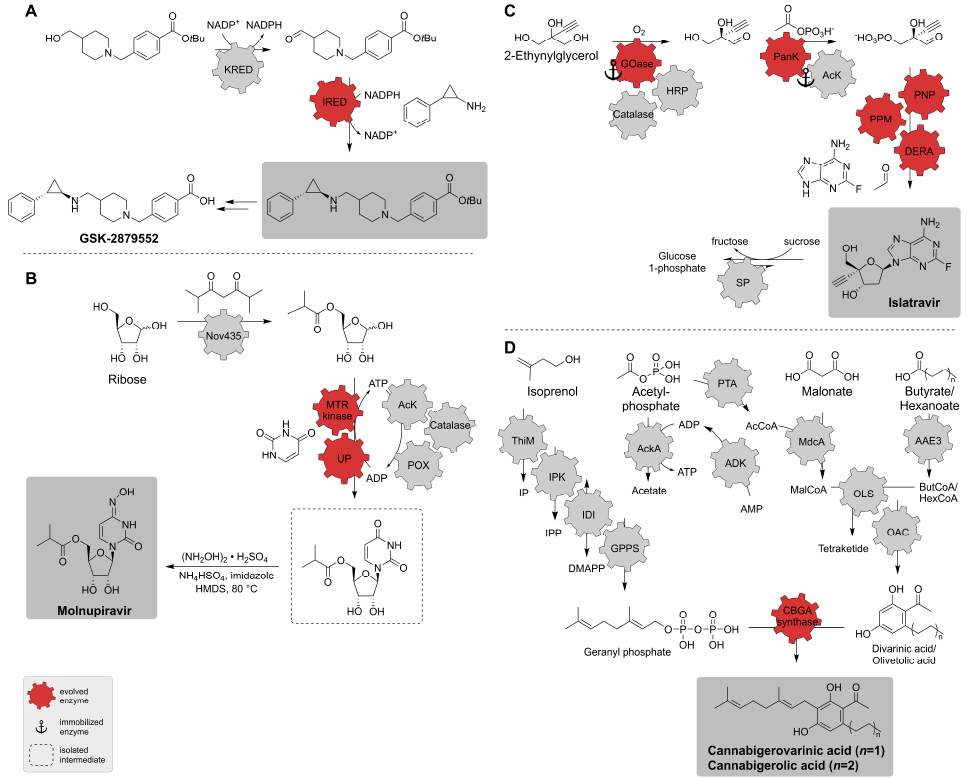
Figure 14. ( A ) Enzyme cascades for the synthesis of GSK-2879552 [34], ( B ) Molnupiravir